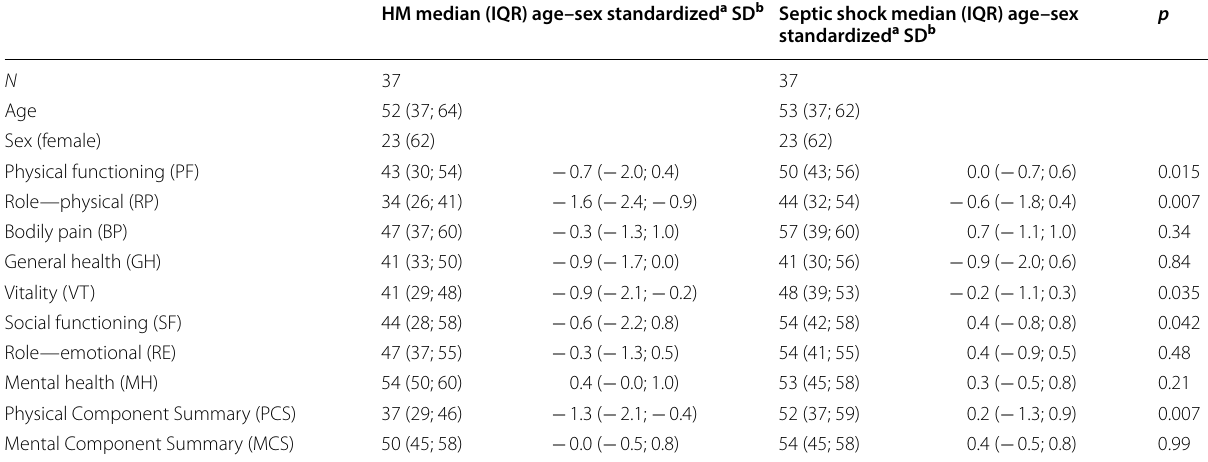
a SF36 values are centred around 50 (i.e. values > or < 50 reflect values higher or lower than age–sex standardized values in the general French population) b SF36 values are centred around 0 (i.e. values > or < 0 reflect values higher or lower than age–sex standardized French values in the general French population, in standard deviation